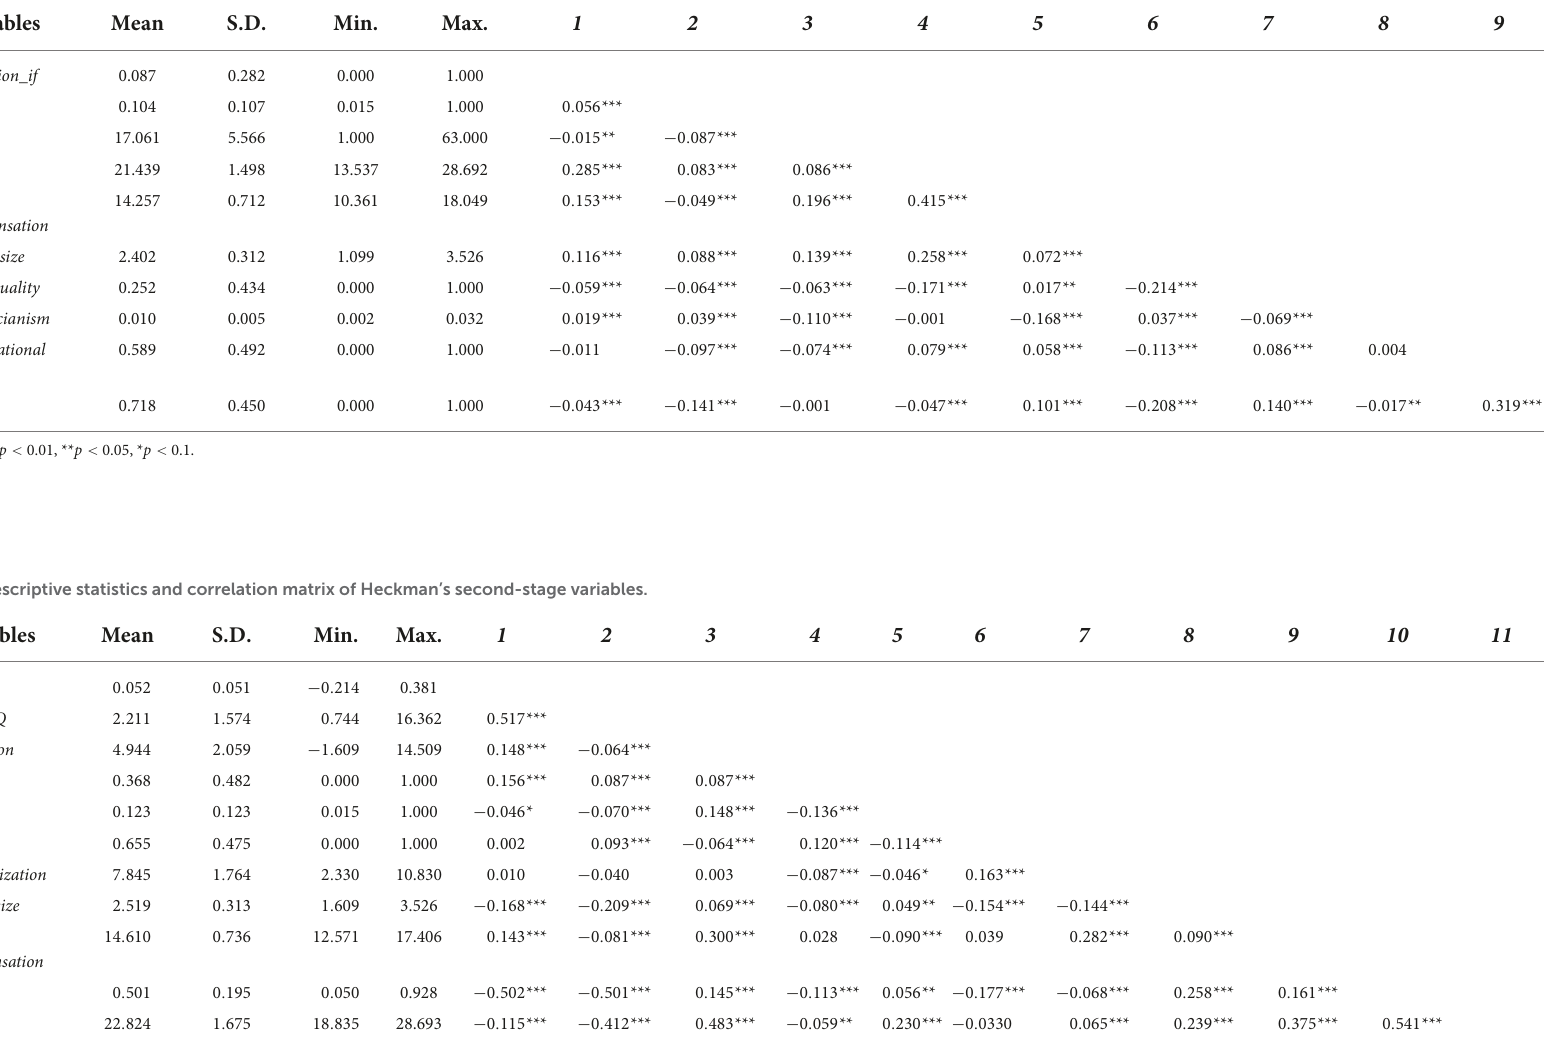
TABLE 3 Descriptive statistics and correlation matrix of Heckman’s first-stage variables.